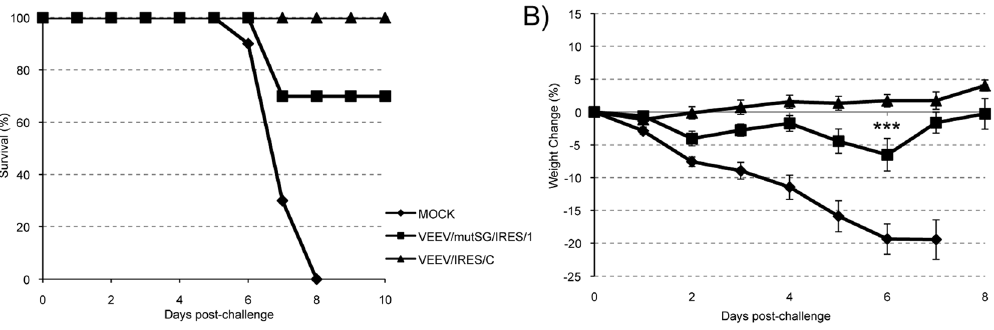
Figure 8. Protection against challenge following vaccination of infant mice. Six-day-old mice were inoculated SC with 5 6 10 4 PFU of VEEV TC-83 or IRES-based viruses. Animals were challenged 6 weeks post-vaccination with 10 4 PFU SC of VEEV IC strain 3908 and monitored daily for survival (A) and weight change (B), with no deaths recorded after day 8 post-challenge. ***=P , 0.0001.